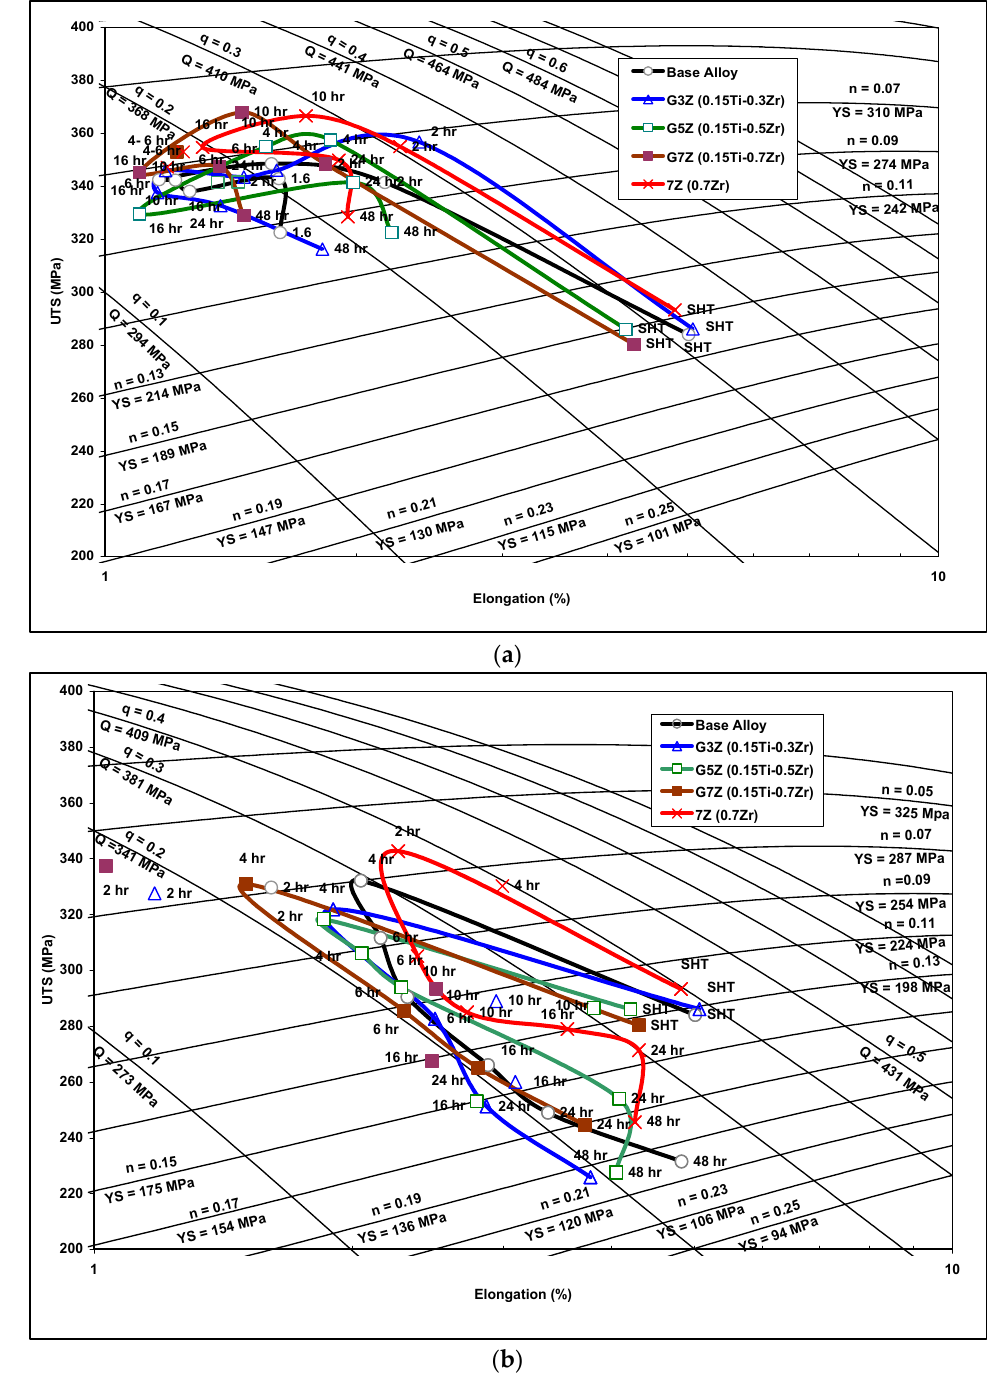
Figure 12. Quality index charts for Zr-Ti alloys at: ( a ) 180 ◦ C and ( b ) 220 ◦ C aging temperatures, showing the variation in alloy quality with aging time. Note the segregation of most of the points in ( a ) in the range of 330–400